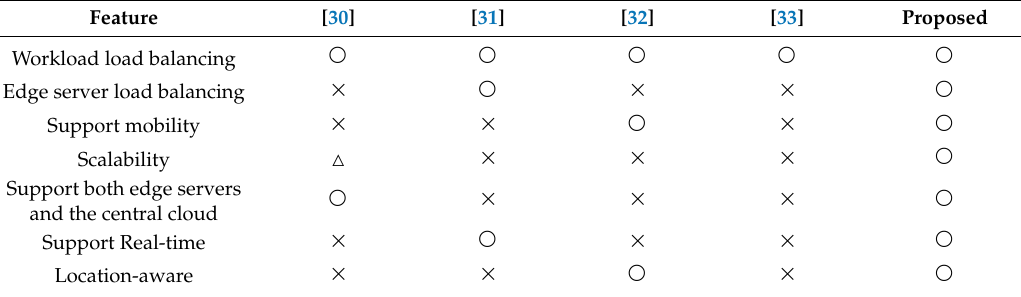
Table 1. Feature comparison with previous studies.